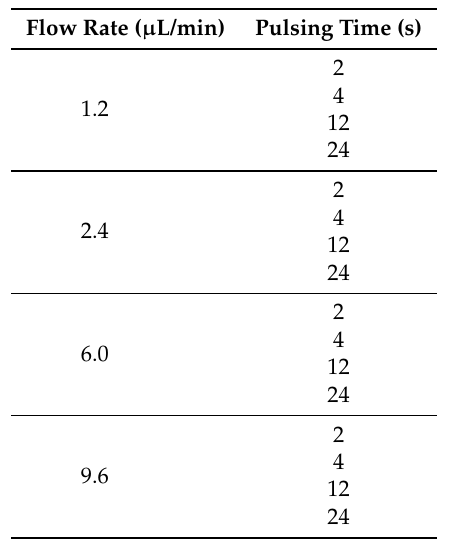
Table 1. Flow rates and pulsing times used in the